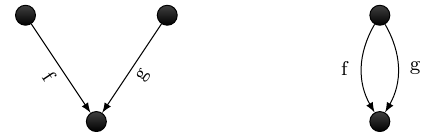
Fig. 2. Formalization of the file system as a graph